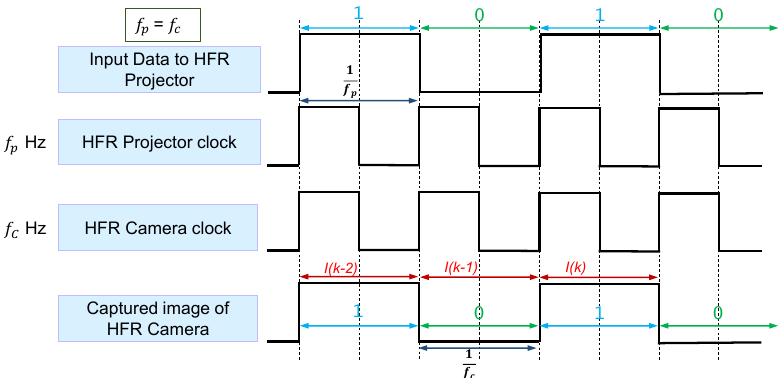
Figure 4. Timing diagram of visual-feedback-based projector–camera